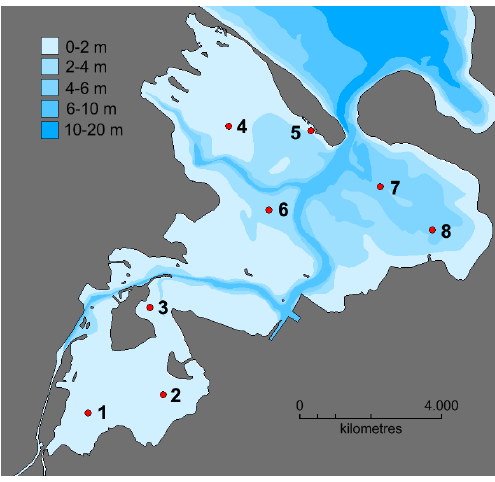
Figure 1. Map of Odense Fjord (55 ◦ 29 (cid:48) 15 (cid:48)(cid:48) N, 10 ◦ 31 (cid:48) 09 (cid:48)(cid:48) E) show- ing the eight stations, where sediments were sampled for the long- term degradation experiment. Gray color indicates land and differ- ent shades of blue indicate water